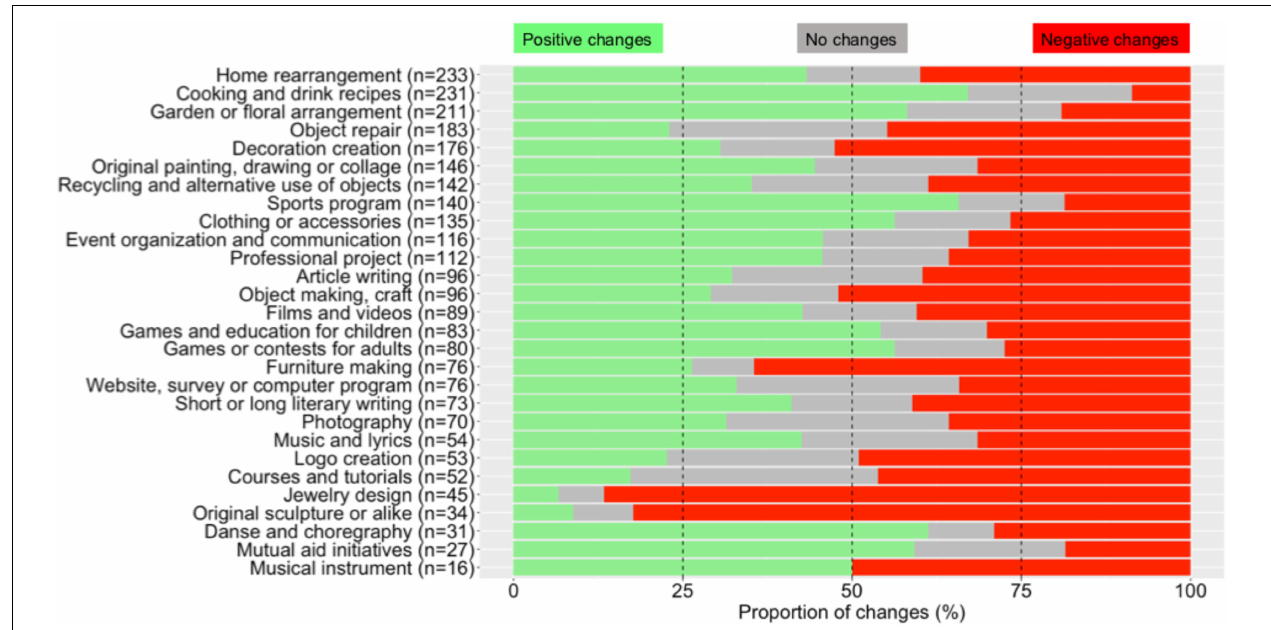
FIGURE 2 | Frequencies and changes in activities. Proportions of changes across subjects regarding each of the 28 activities on the list for positive changes (in green), negative changes (in red), or no changes (in gray). Changes refer to a difference reported by each subject between the five last years preceding the lockdown and the lockdown period. Each activity is named by its English-translated quick name (see Supplementary Table 4 ) and is associated with the number of subjects who answered this question (i.e., subjects who did the activity during the last 5 years, including the lockdown period). Activities are sorted in descending order based on the number of subjects involved in this